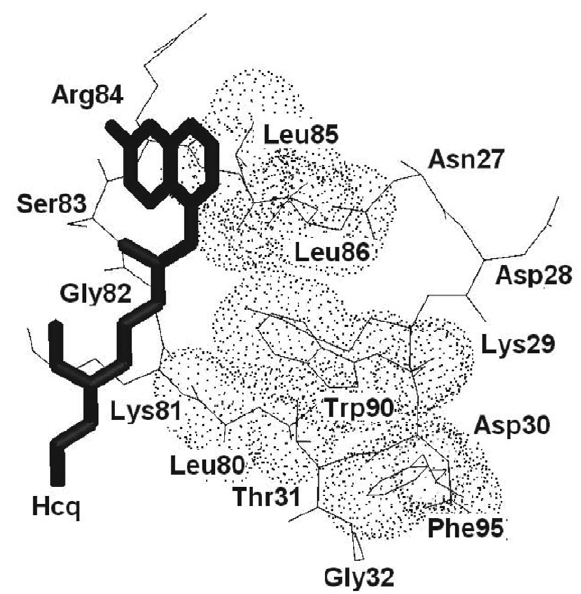
Figure 5. Hcq (bold sticks) that is docked in the binding site of the Val84Arg mutant of hCoV-OC43 S. The P1 (Leu85, Leu86 and Trp90) hydrophobic pocket (dots) accommodates the aromatic core scaffold of Hcq. No electrostatic contacts are